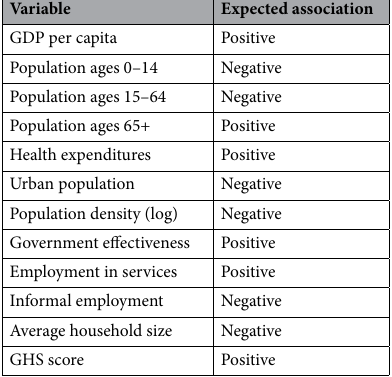
Table 2. Hypotheses regarding the association between country-specific NPI effects and country characteristic. Positive (negative): Increase in variable increases (decreases) country-specific NPI effect. GDP: gross domestic product; GHS: global health